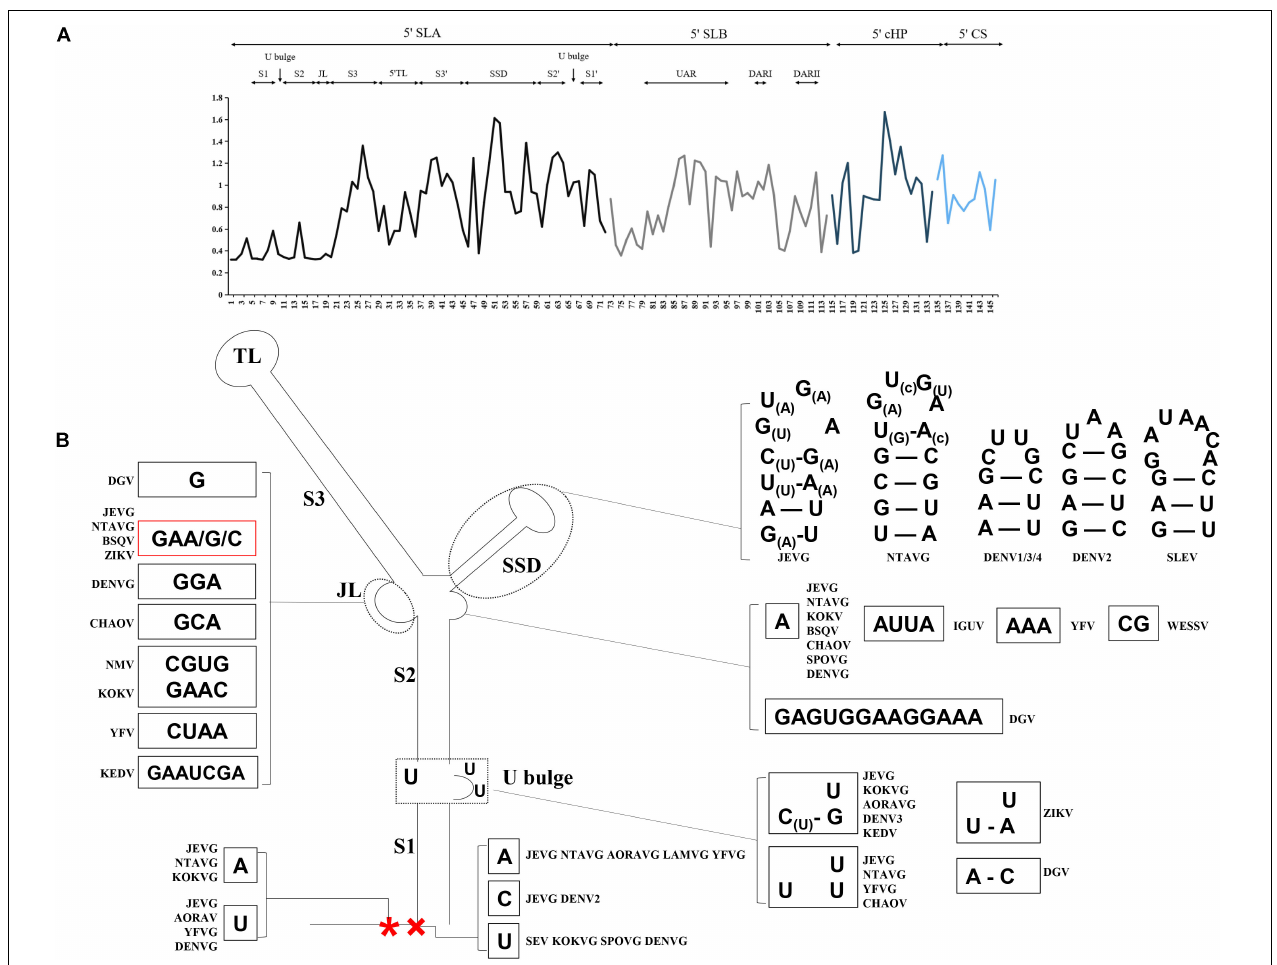
FIGURE 3 | (A) Mean relative evolutionary rates are shown for each site of the 5 (cid:48) cis- acting RNA. The analysis involved 25 nucleotide sequences from all the MBFVGs, spanning the 5 (cid:48) SLA, 5 (cid:48) SLB, 5 (cid:48) cHP and 5 (cid:48) CS. Evolutionary analyses were conducted in MEGA6. These rates are scaled such that the average evolutionary rate across all sites is 1. This means that sites showing a rate < 1 are evolving slower than average, and those with a rate > 1 are evolving faster than average. (B) MBFV structured promoter 5 (cid:48) SLA features divergent nucleotides. The 3rd A/U nucleotide (*) undergoes a nucleotide substitution, and the 4th nucleotide ( × ) shows sequence and structure divergences even in the same JEVG or